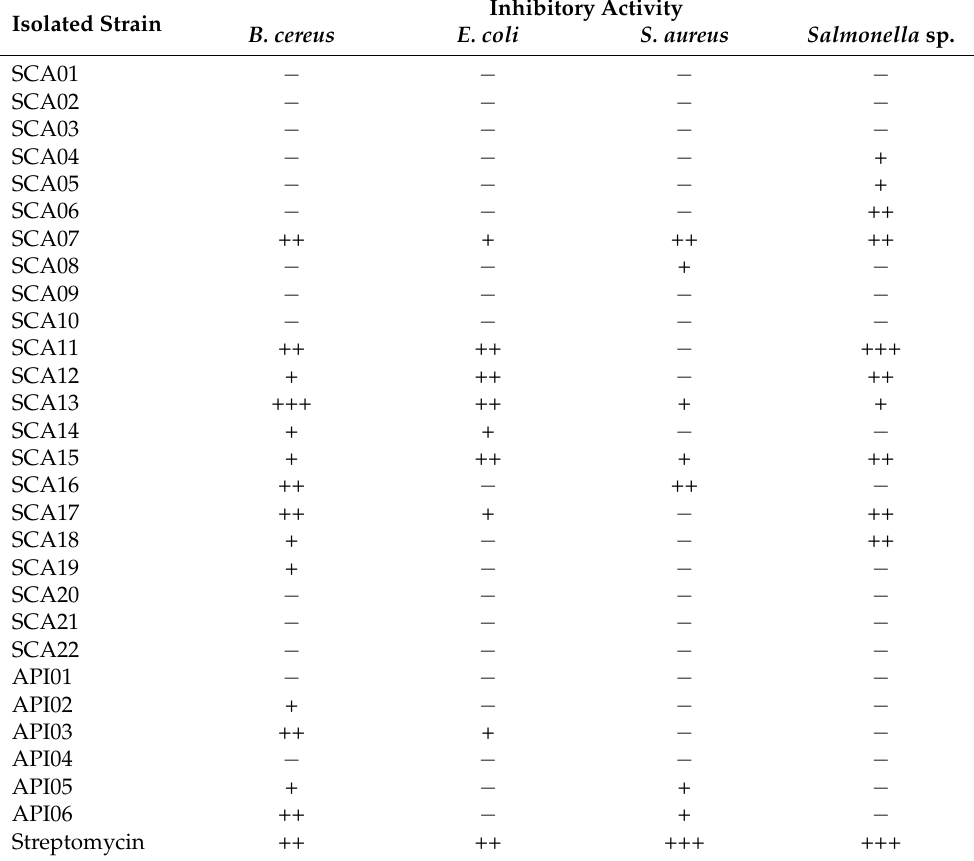
Table 2. Antimicrobial selection test of strains isolated from the honey of S. aff. postica (SCA) and A. mellifera (API). ( − ) No activity, (+) Low activity, (++) Medium activity, (+++) High activity. Isolated Strain